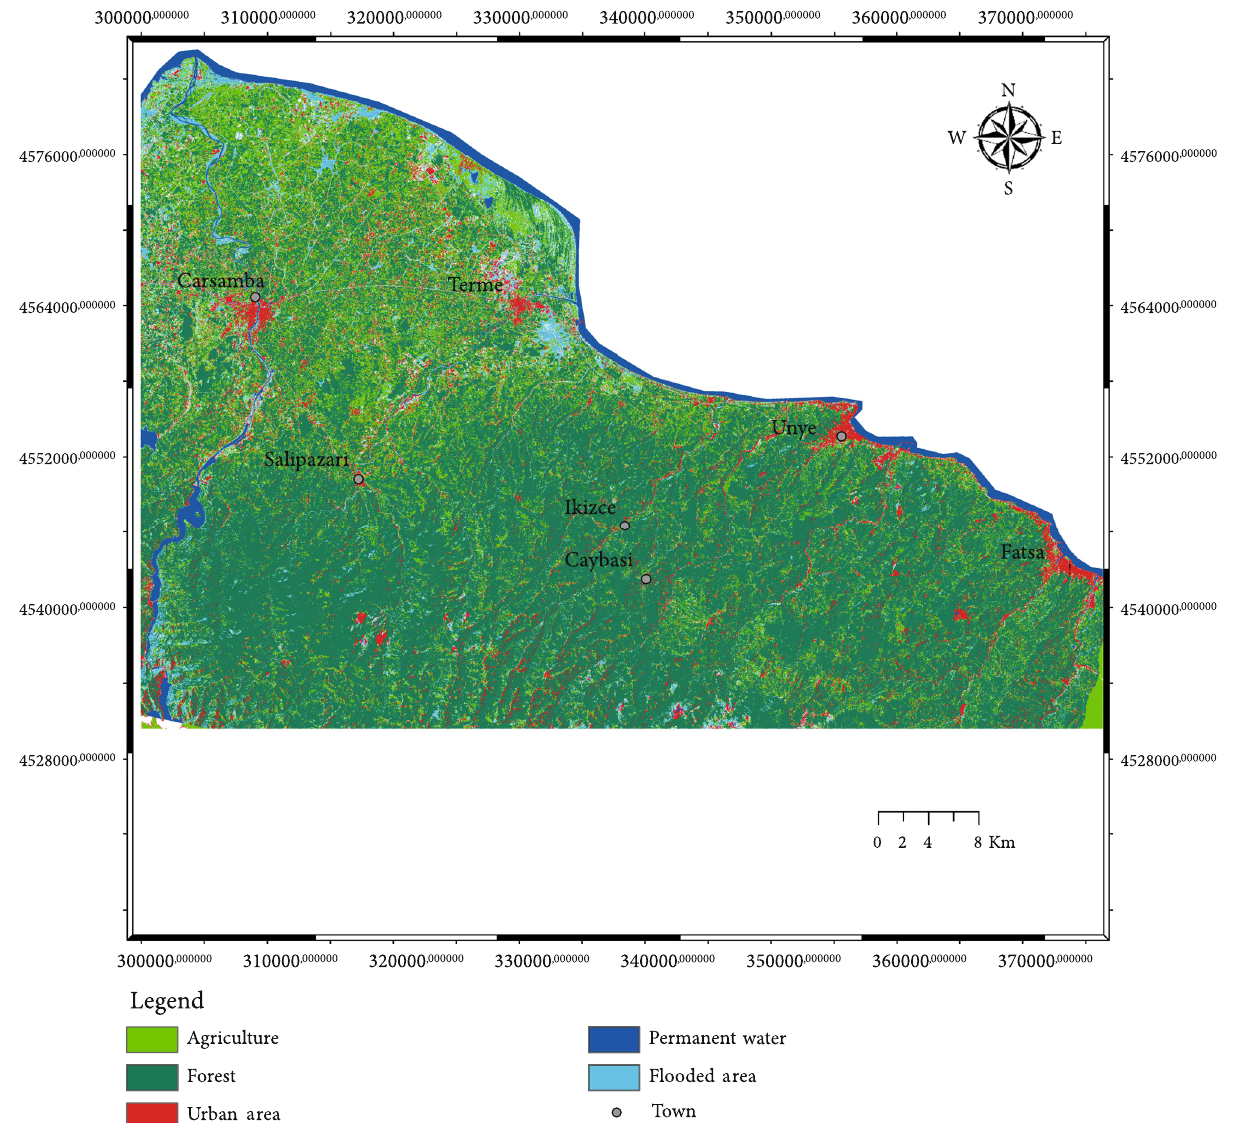
Figure 11: Result of the fl ood analysis produced for the whole area a ff ected by fl